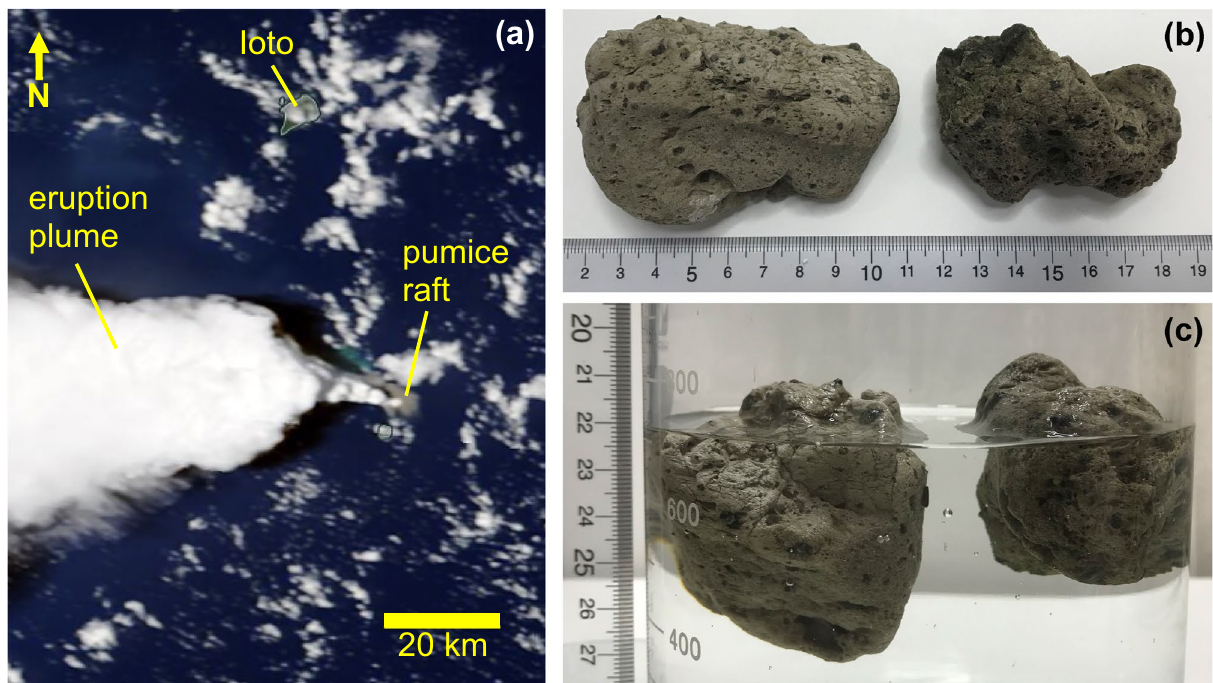
Figure 1. ( a ) Satellite image taken during the eruption on 13th August 2021. Pumice raft (grey mass) is accumulating on the sea surface above the submarine vent and beginning to disperse to the northwest. Image source: NASA Worldview, taken by Terra satellite during its descending/day orbit at 2021/08/13 00:50 UTC (09:50 JST). ( b ) Two pieces of raft pumice collected from Japan coastline (Ito port, Chiba) on 9th